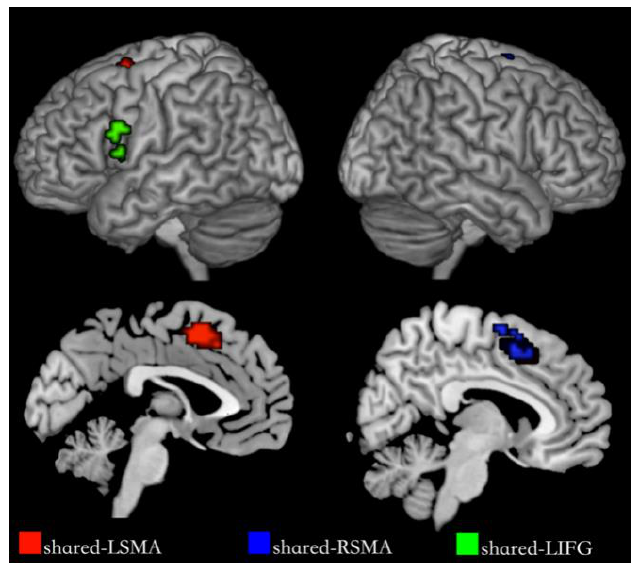
Figure 5. Shared regions for NA and NV. The red regions are shared-LSMA, the blue regions are shared-RSMA and the green regions are shared-LIFG.